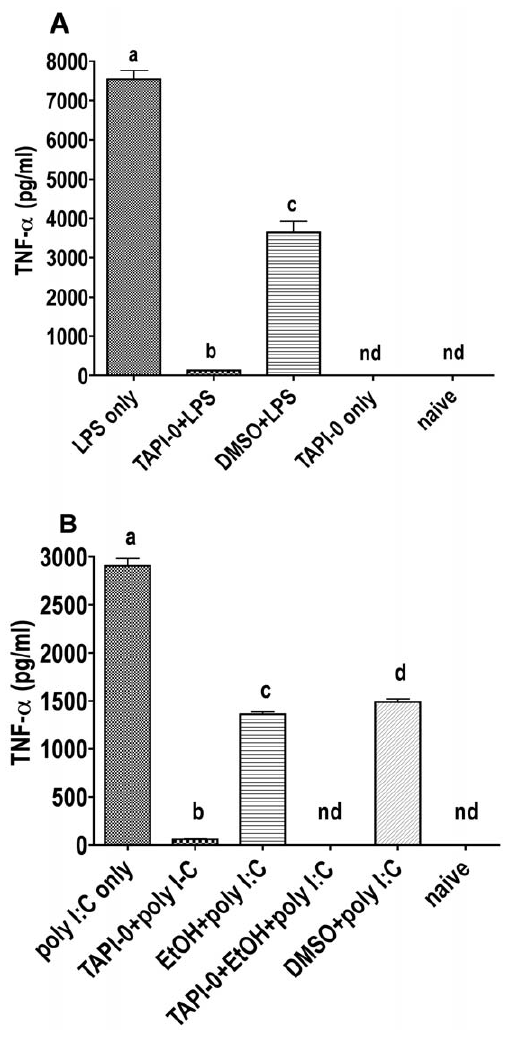
Figure 4. Effect of TACE inhibition on the LPS and poly I:C induced TNF- a response in RAW264.7 cells. TNF- a levels were measured by ELISA from cell culture medium immediately after collection. Each group contained 6 samples. Naive groups received no treatment. A Cells were treated with 25 m g/ml TAPI-0, 5 m l/ml DMSO, and/or 100 ng/ml LPS. Treatments were given at the same time point and cells were incubated 2 h. B Appropriate groups were treated with 86.8 mM EtOH and incubated 30 min. Cells were treated with 25 m g/ml TAPI-0, 5 m l DMSO, and/or 50 m g/ml poly I:C, and incubated further 2 h. Bars with no shared letters are significantly different (p , 0.05; nd=not detectable).